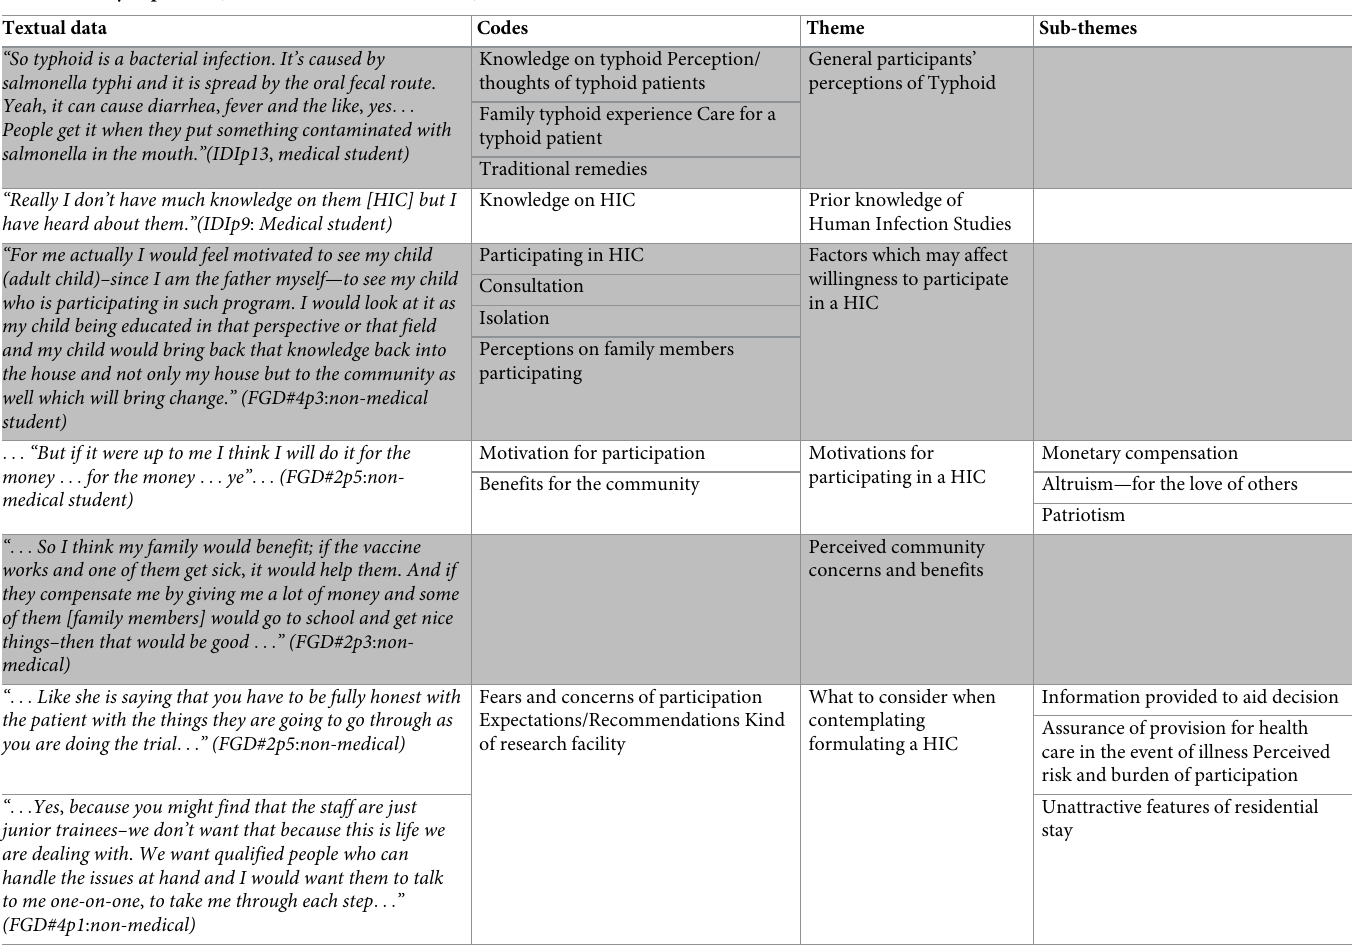
Table 3. Analysis process (codes, themes and